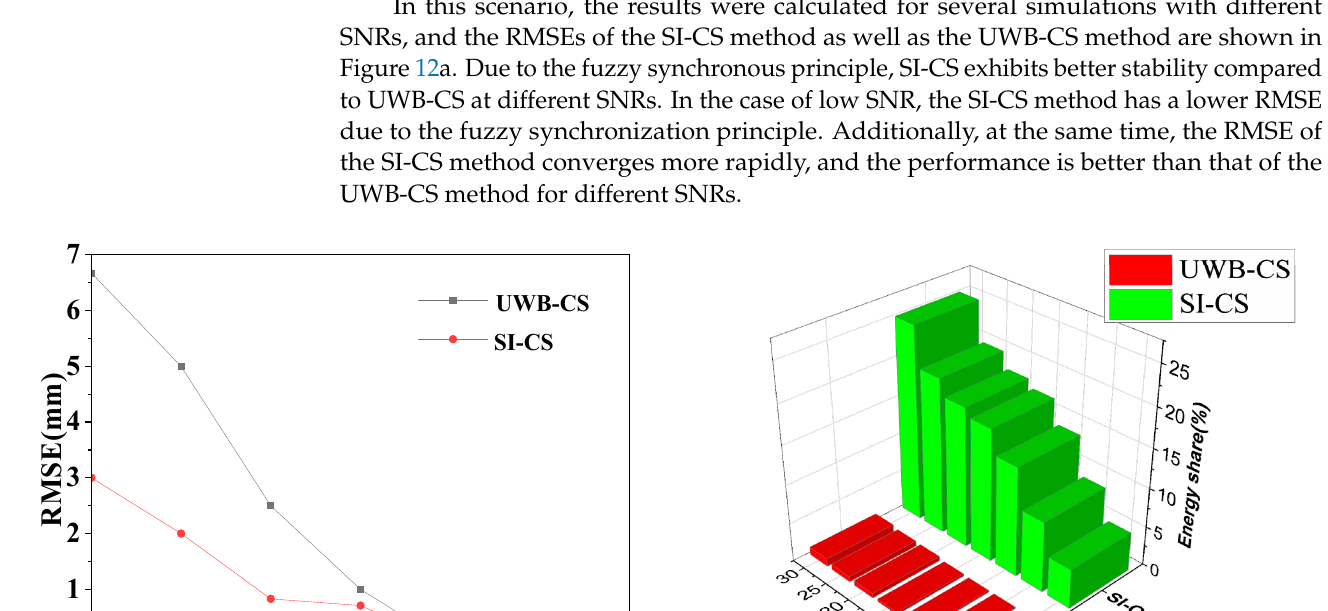
Figure 7. ( a ) The RMSEs of the UWB-CS method and the SI-CS method. ( b ) The energy share of the UWB-CS method and the SI-CS method.